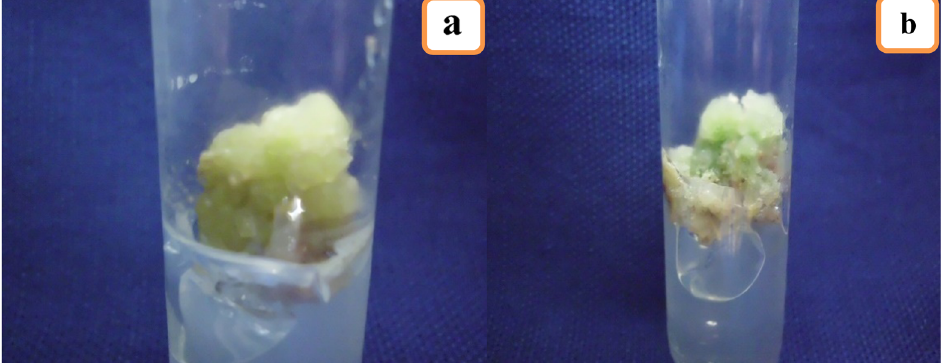
Figure 5: Maximum proliferation in callus cultures of A. absinthium in: ( a ) Ag and Cu NPs ( 1:2 ) + TDZ, ( b ) Ag and Cu NPs ( 2:1 ) +